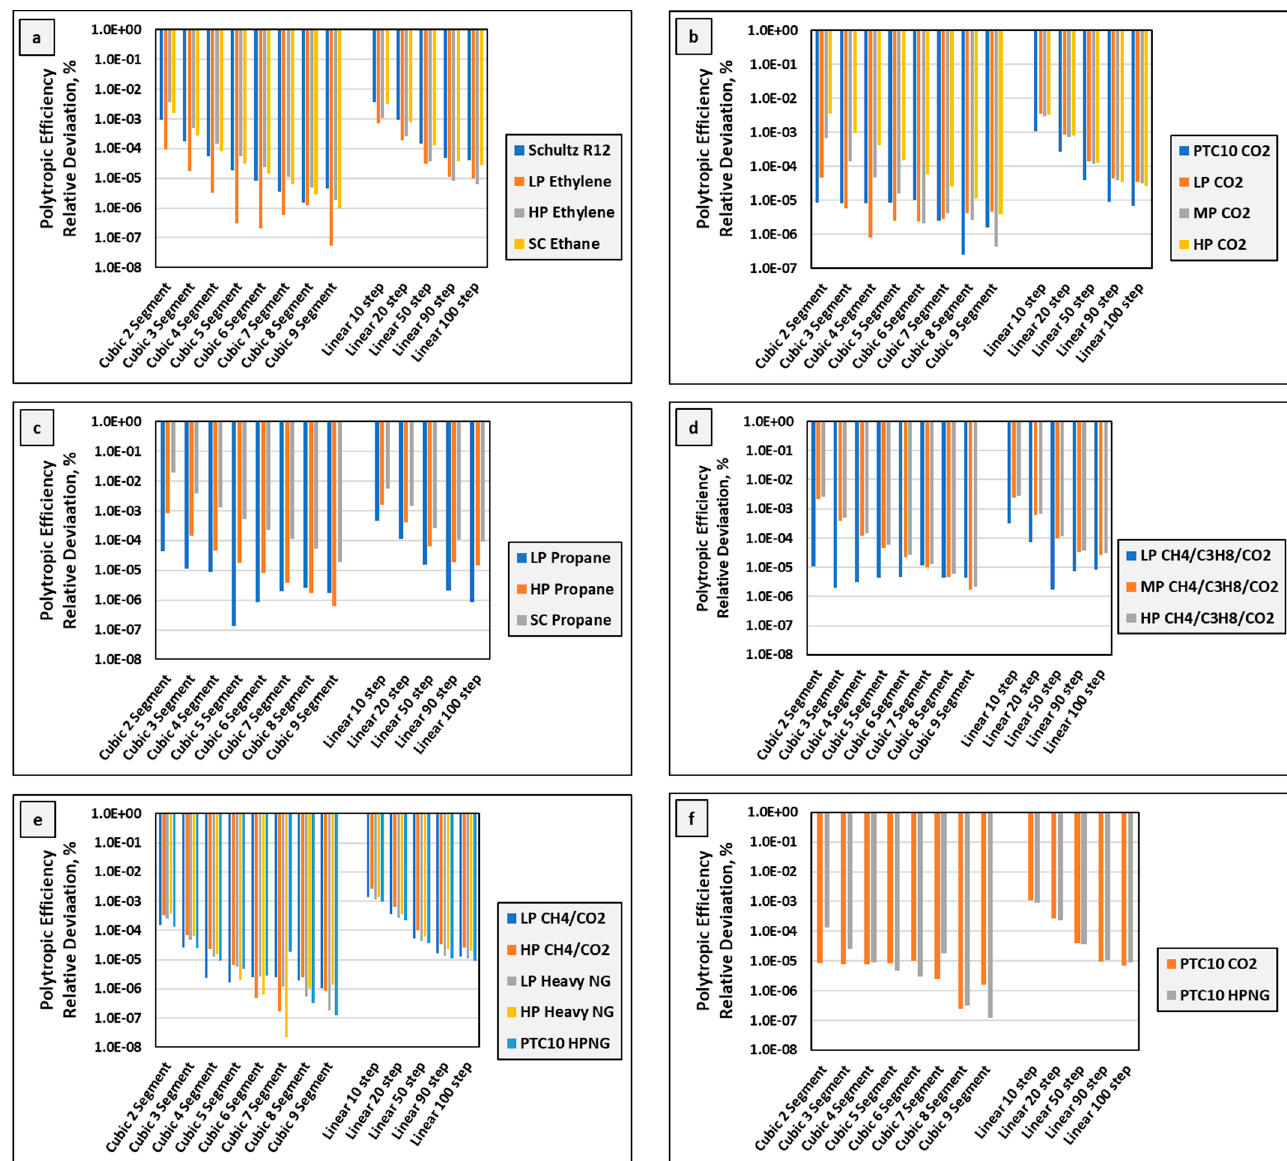
Figure A4. ( a – f ) Summary comparison of results for linear multi-step and cubic polynomial multi-segment methods.